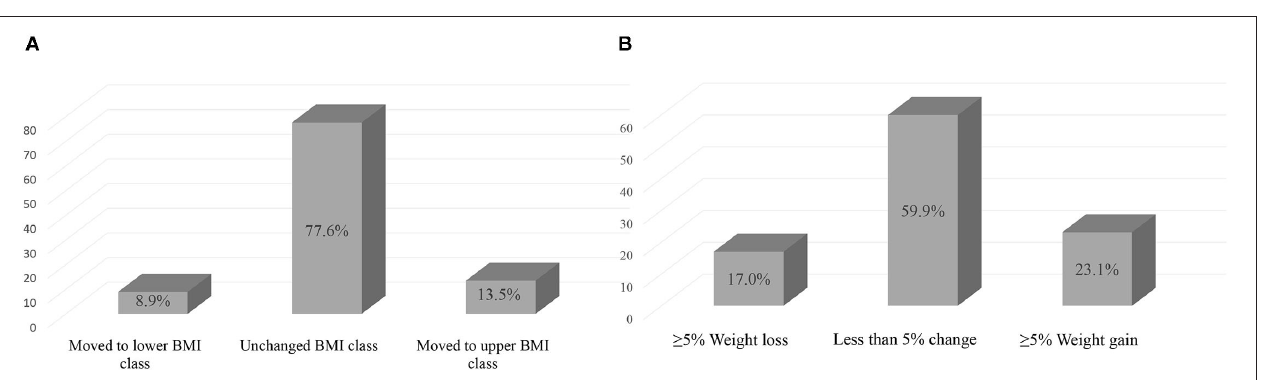
FIGURE 3 | Changes in (A) BMI classification and (B) weight from pre-2020 to